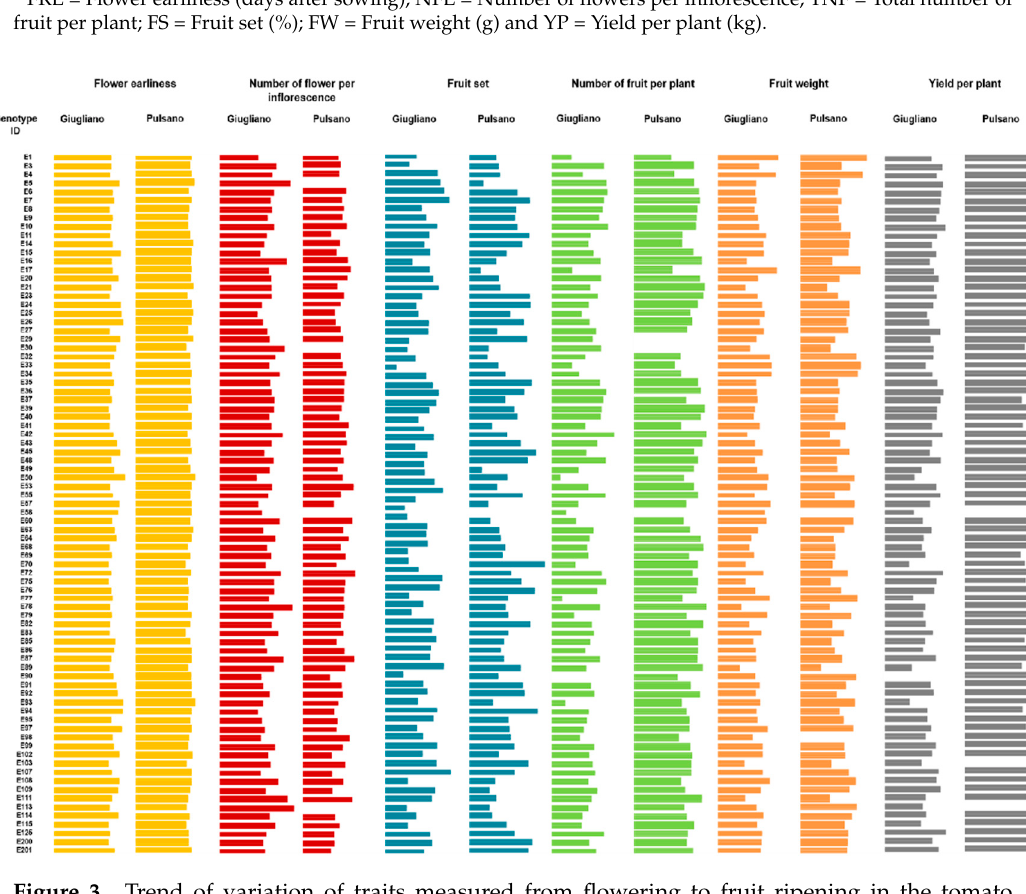
Figure 3. Trend of variation of traits measured from flowering to fruit ripening in the tomato landrace collection. Each bar represents the mean of values of flower earliness, number of flowers per inflorescence, percentage of fruit set, total number of fruit, fruit weight and yield per plant. All trait values were log10 transformed to better fit a normal distribution, except than fruit set.